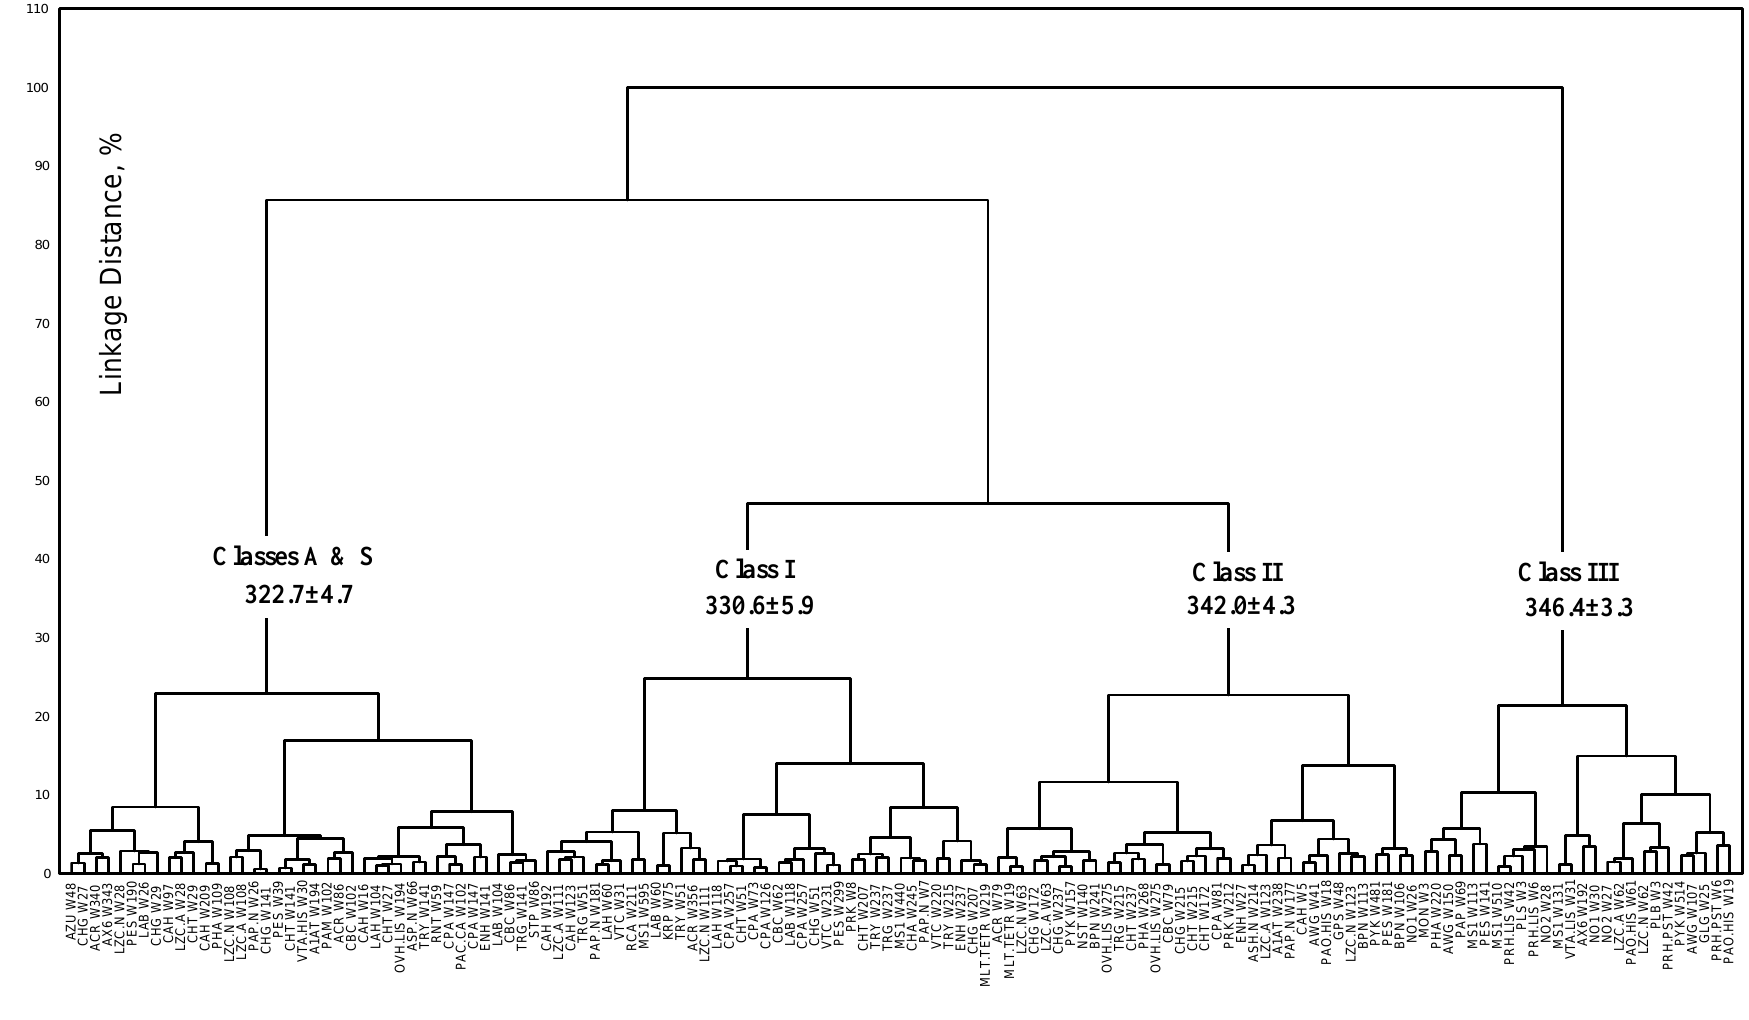
Figure 8. The hierarchical tree (dendrogram) constructed based on the canonical variate (Root 1). Figure is taken from the reference